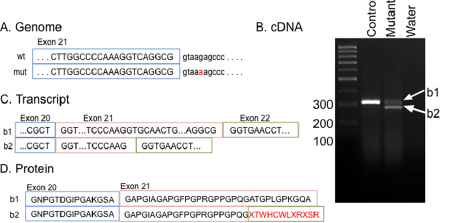
Fig. 5. The MC13 mutations alters splicing of Col2a1 . (A) The ENU mutation is in the intron after exon 21 (red). (B) Analysis of the Col2a1 cDNA transcript in this area of the gene indicates an abnormal splice variant in the mutant sample (b2) in addition to the expected PCR product (b1). (C) The b2 PCR product represents an mRNA that does not include all of exon 21, but prematurely transitions to exon 22. (D) The abnormal transcript codes for a premature stop codon in exon 21 which is predicted to translate a protein approximately 30% the length of wild-type.